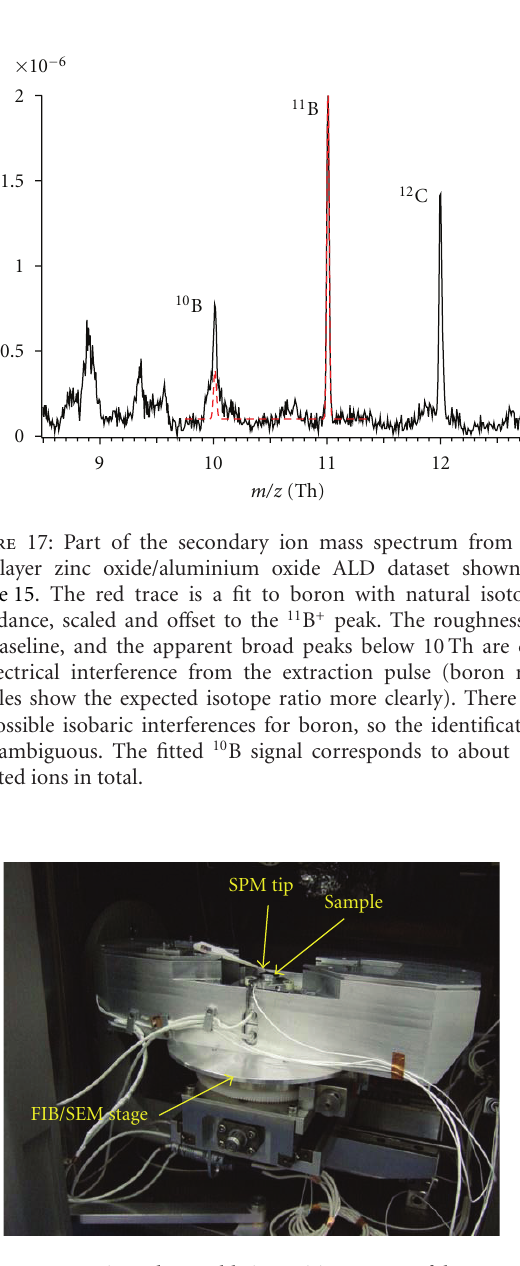
Figure 18: SPM tip and assembly in position on top of the FIB/SEM stage, with the stage in its “home” position. The SPM assembly is simply bolted to the